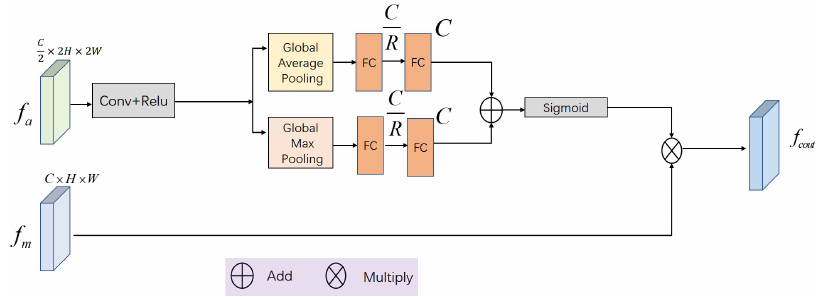
Figure 4. Block diagram of the Channel attention